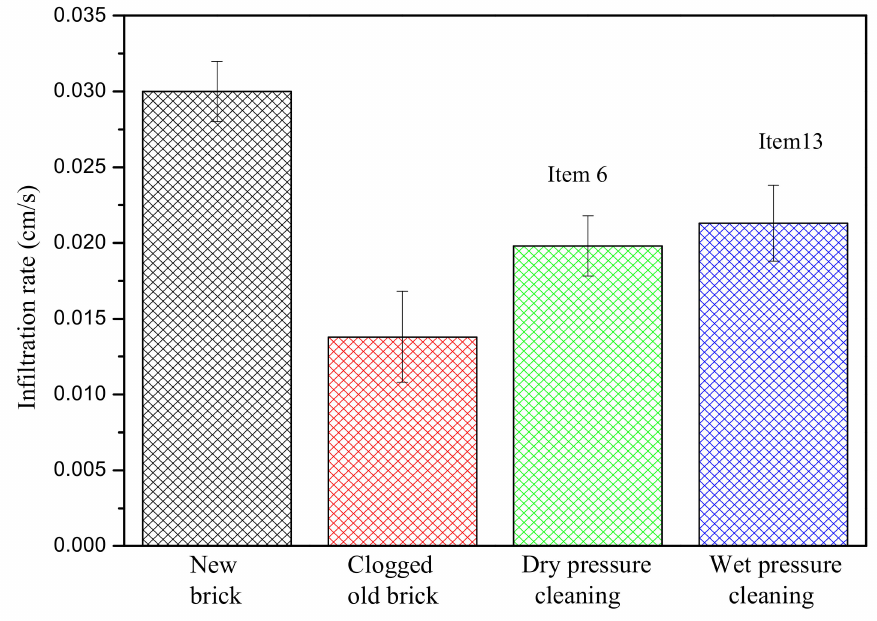
Figure 6. Recovery effect of pressure washing with different moisture